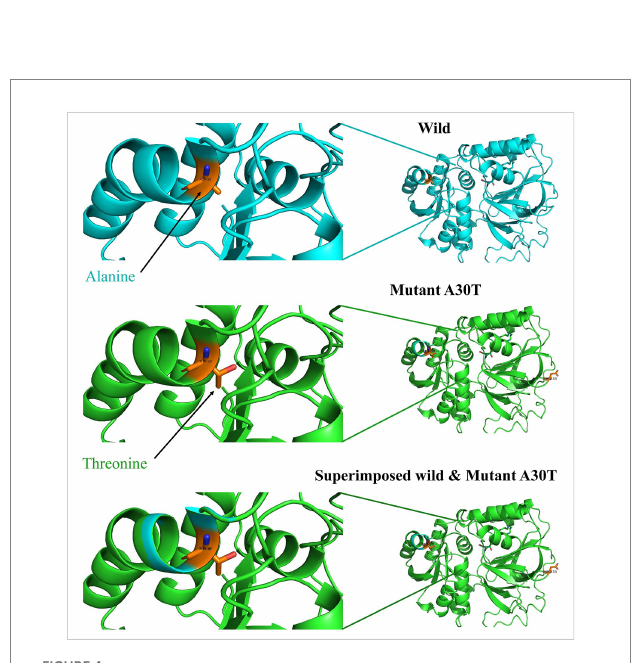
FIGURE 4 Protein models of SPHK1 wild-type and mutated proteins. Root mean square deviation (RMSD) for the superimposed: